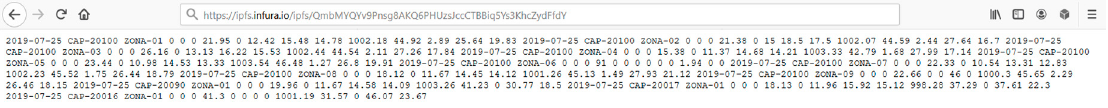
Figure 12. IPFS content through public Figure 12. IPFS content through public gateway. Figure 12. IPFS content through public gateway. Figure 12. IPFS content through public gateway. Figure 12. IPFS content through public gateway.